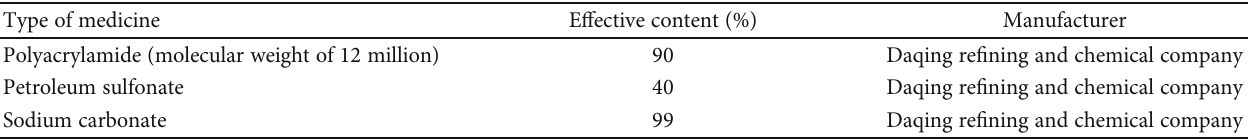
Figure 1: Quantitative analysis of remaining oil in frozen slicing. Table 1: Component chemical parameters.